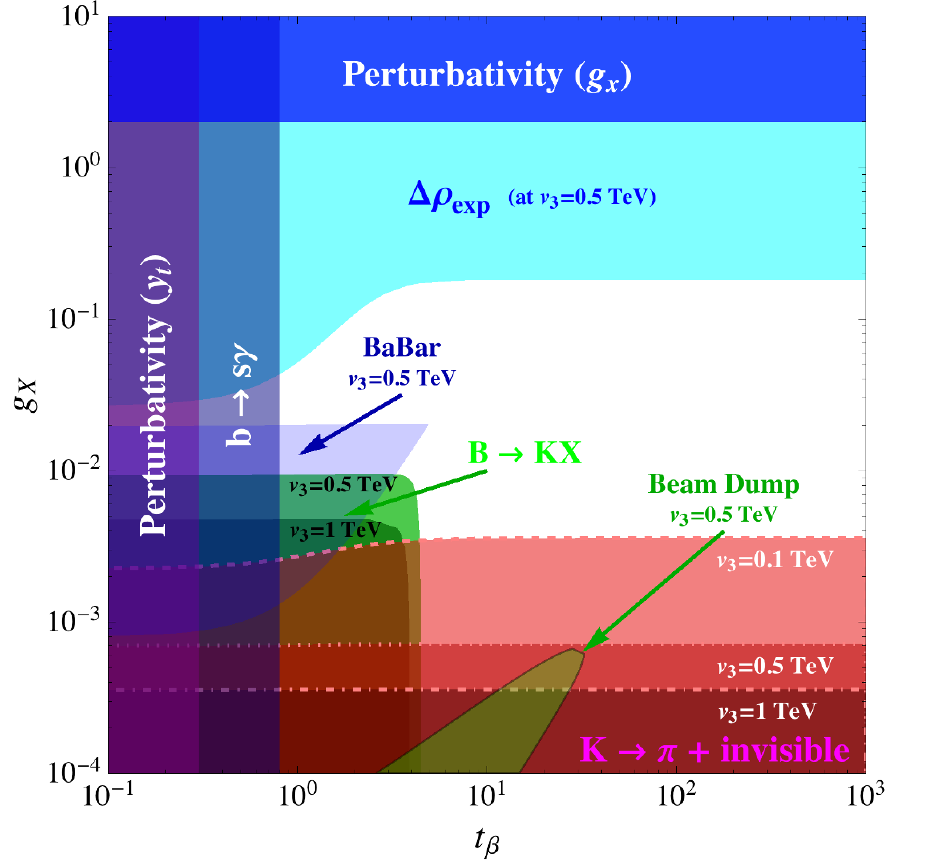
Figure 2 . Bounds on the ( t (cid:12) ; g X ) plane coming from di(cid:11)erent theoretical and experimental sources. The colored regions are